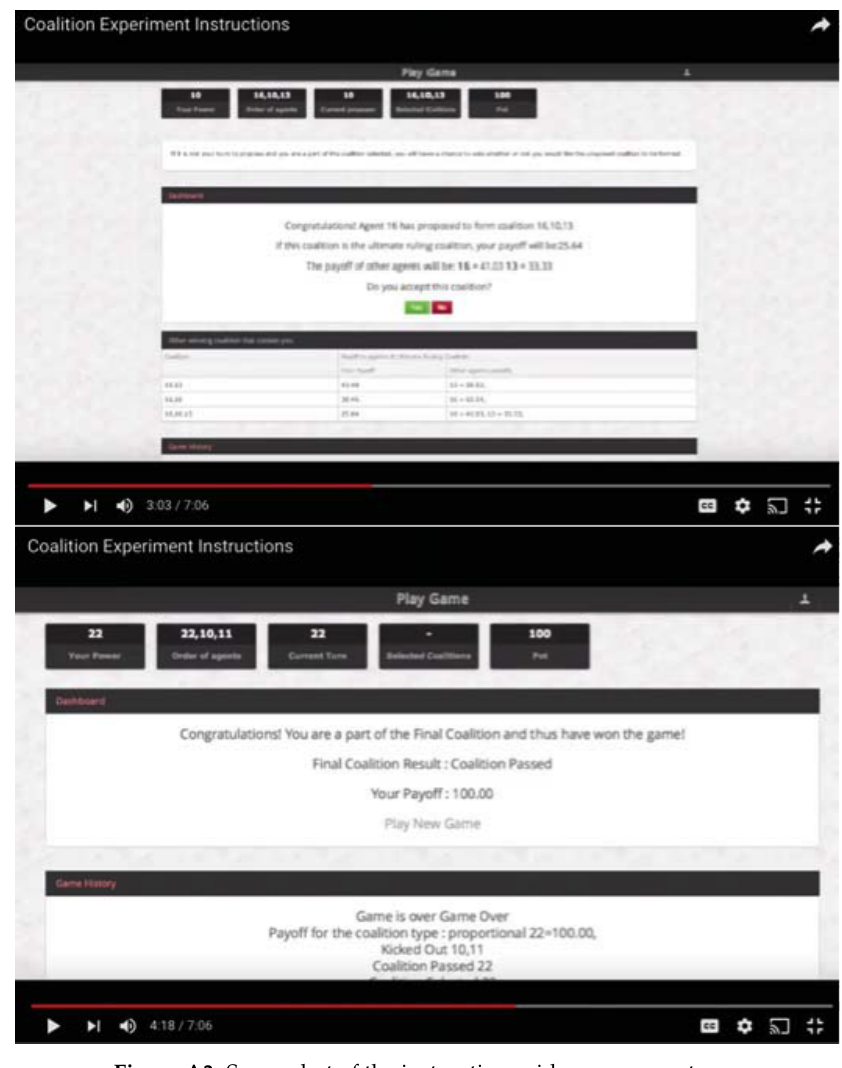
Figure A3. Screenshot of the instructions video:response